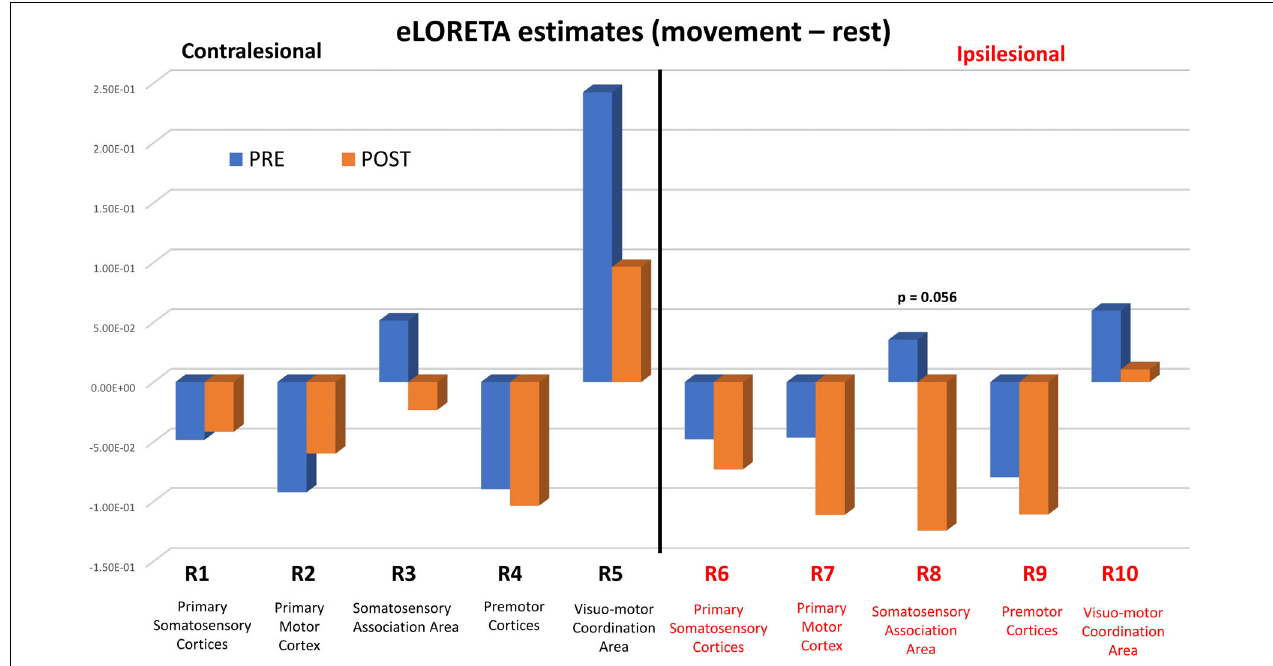
FIGURE 4 | eLORETA estimates PRE (blue bars) and POST (orange bars) BCI intervention. eLORETA estimates between the two conditions [Movement – Rest] were based on measured EEG spectral power data in the Mu band [8–12 Hz] for each of the 10 regions of interest (ROI #1-10). P values refer to statistical group comparisons of Post vs. Pre estimates using a ROI-based one-tailed t -test. The p values reported are uncorrected for multiple comparisons.